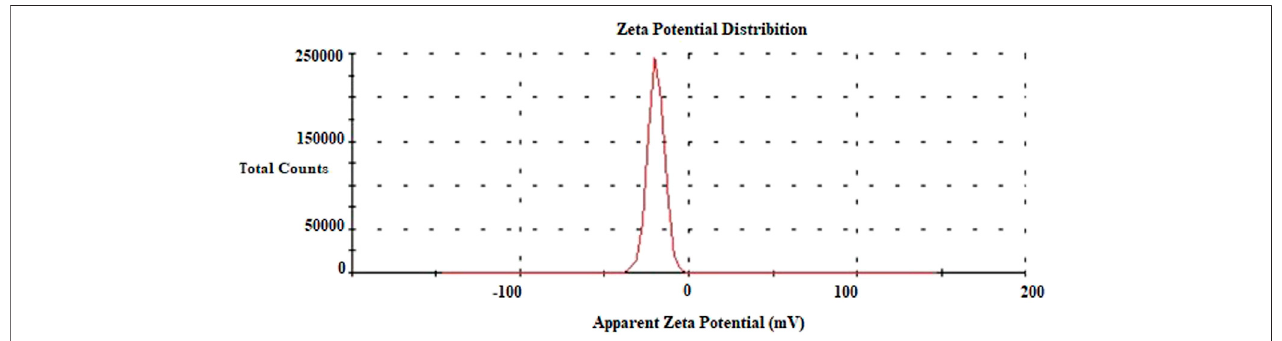
FIGURE 8 | Zeta potential data of AgNPs.